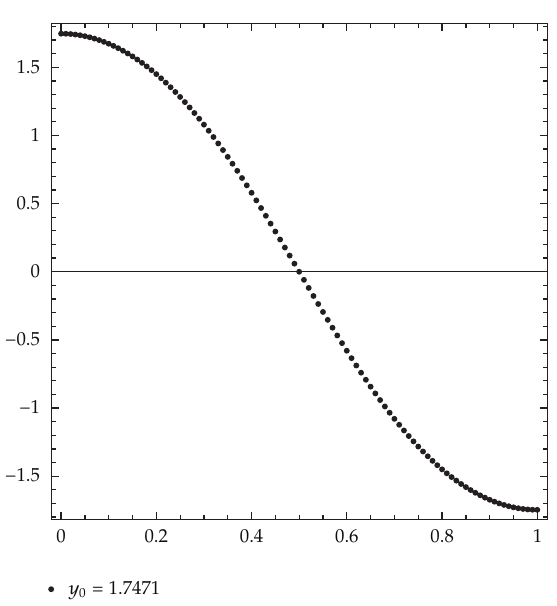
Figure 3: Solution of (cid:2) 1.2 (cid:3) corresponding to the initial values y 0 for π 2 ≤ λ (cid:5) 15 < 4 π 2 .